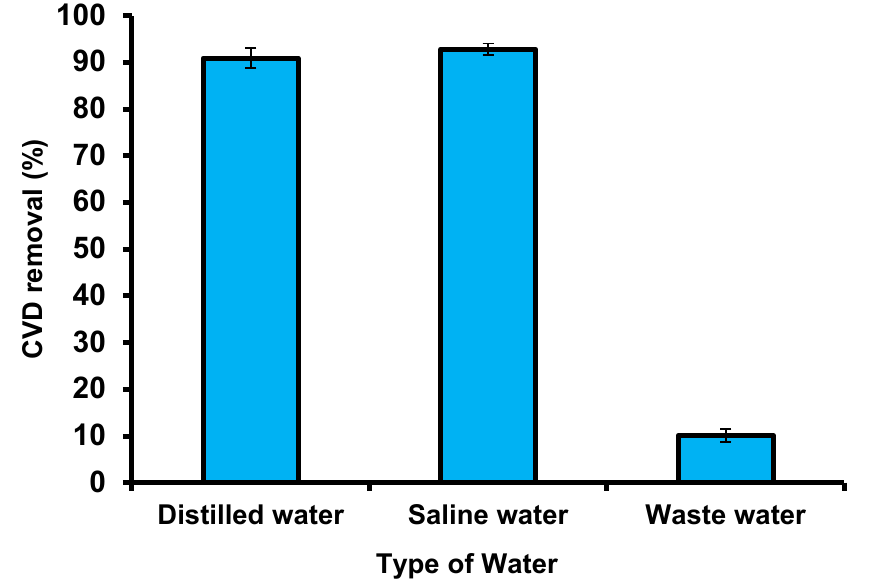
Figure 18. Removal of CVD from different solutions using S. costatum .